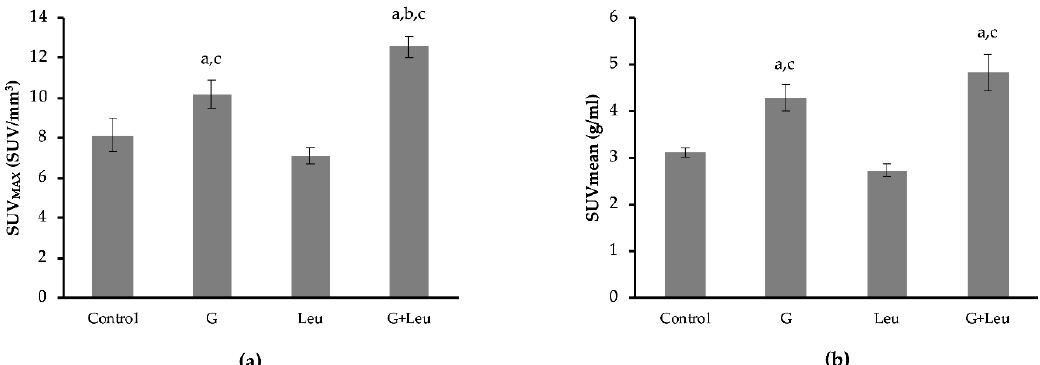
Figure 2. Interscapular brown adipose tissue (IBAT) standardized uptake value (SUV) for control, glucose (G), leucine (Leu), and the combination of G + Leu-treated mice. (a) Group mean data for the maximum SUV (SUV MAX , units in SUV/mm 3 ) was calculated for IBAT for each treatment group. (b) Group mean data for the average SUV across the entire tissue (SUVmean, units in g/mL). Data are expressed as mean ± the SEM. A one-way analysis of variance was performed followed by a Fisher LSD post-hoc. a, denotes significant difference compared to control; b, denotes significant difference compared to G ( p ≤ 0.05); c, denotes significant difference compared to Leu ( p ≤ 0.05). n = 6–8.